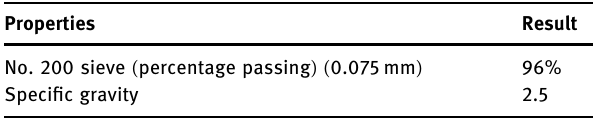
Table 4: Physical characteristics of Portland cement Properties